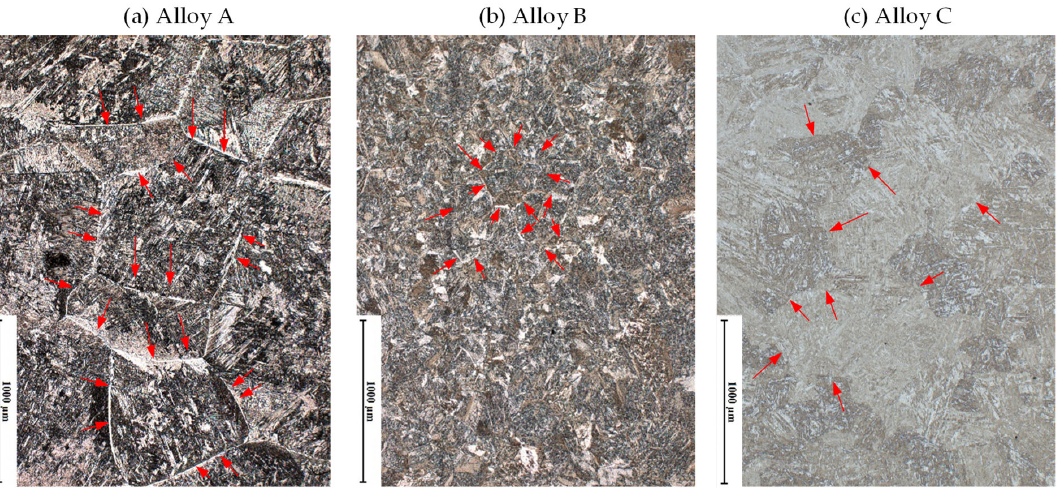
Figure 4. Comparison of the prior austenite grain sizes after austenitization at 1350 °C for 180 s. The red arrows indicate the grain boundaries in ( a – c ). In ( a , b ) the grain boundaries are decorated by allotriomorphic grain boundaries ferrite.